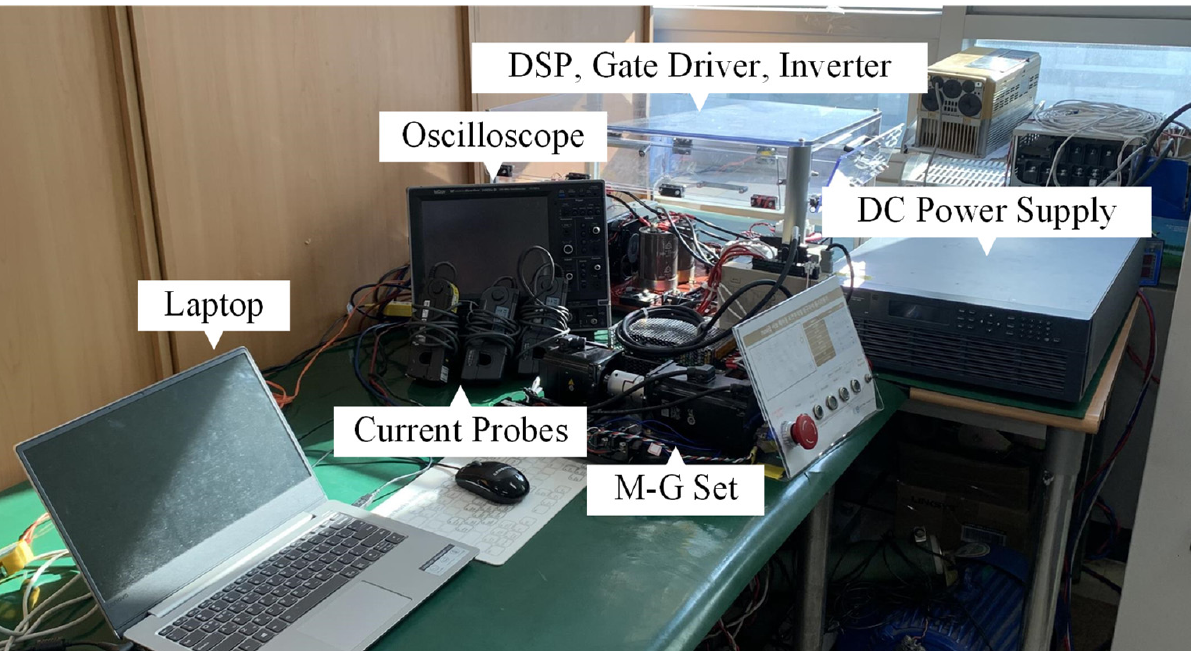
Figure 17. Photo of SPMSM test bench.